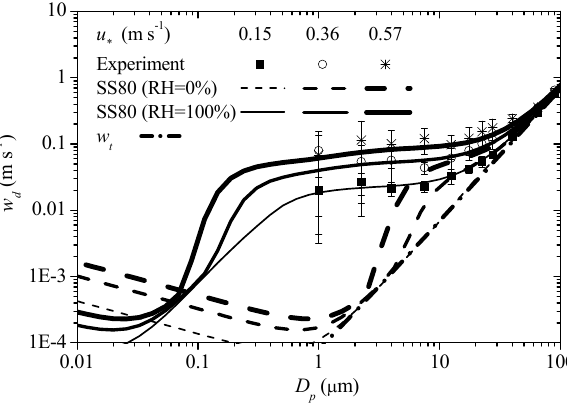
Figure A2. Results of our measurements and the SS80 scheme.